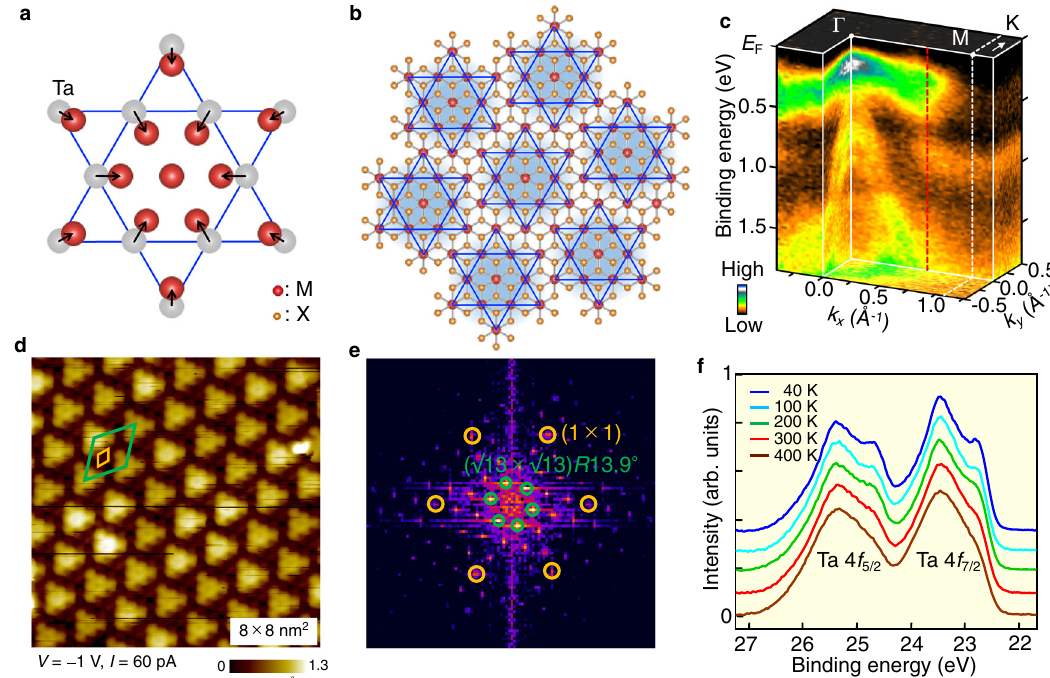
Fig. 1 Schematics of star-of-David clusters and core-level photoemission spectrum of monolayer 1T-TaSe 2 . a Schematics of the displacement of Ta atoms in the star-of-David cluster. M and X represent transition-metal and chalcogen atoms, respectively. b Schematics of crystal structure for monolayer 1T-TaSe 2 and star-of-David clusters with the √ 13 × √ 13 periodicity. c 3D ARPES-intensity plot as a function of 2D wave vector ( k x and k y ) and E B for monolayer 1T-TaSe 2 measured at T = 40 K with the He-I α line ( h ν = 21.218 eV). Hybridization gap ( k x ~ 2/3 Γ M) is indicated by red dashed line. d STM image in a surface area of 8 × 8 nm 2 for monolayer 1T-TaSe 2 on bilayer graphene measured at T = 4.8 K. e Fourier transform image of d . f Temperature dependence of EDC around the Ta-4 f core level measured with h ν = 260 eV for monolayer 1T-TaSe 2